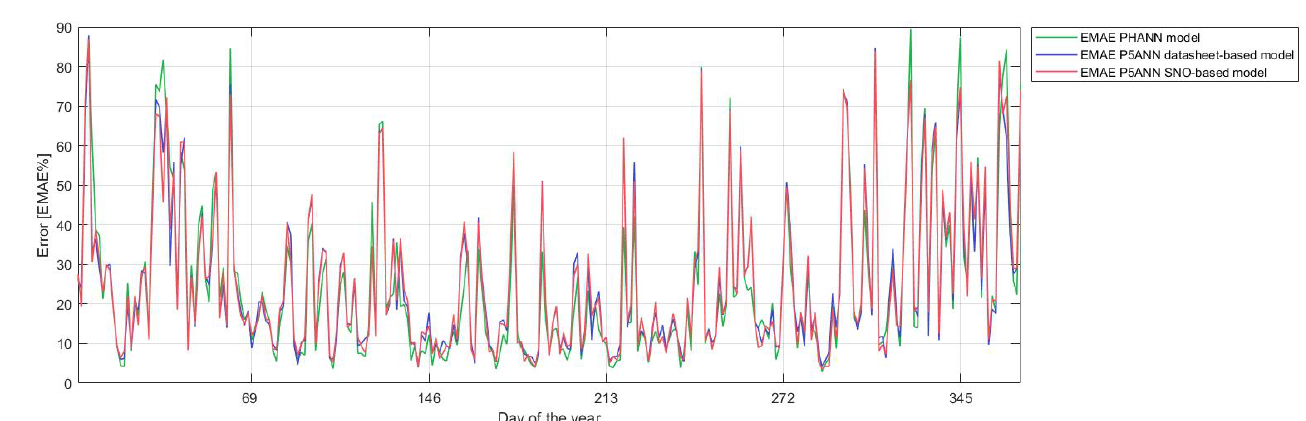
Figure 9. EMAE comparison for the three ANN-based hybrid